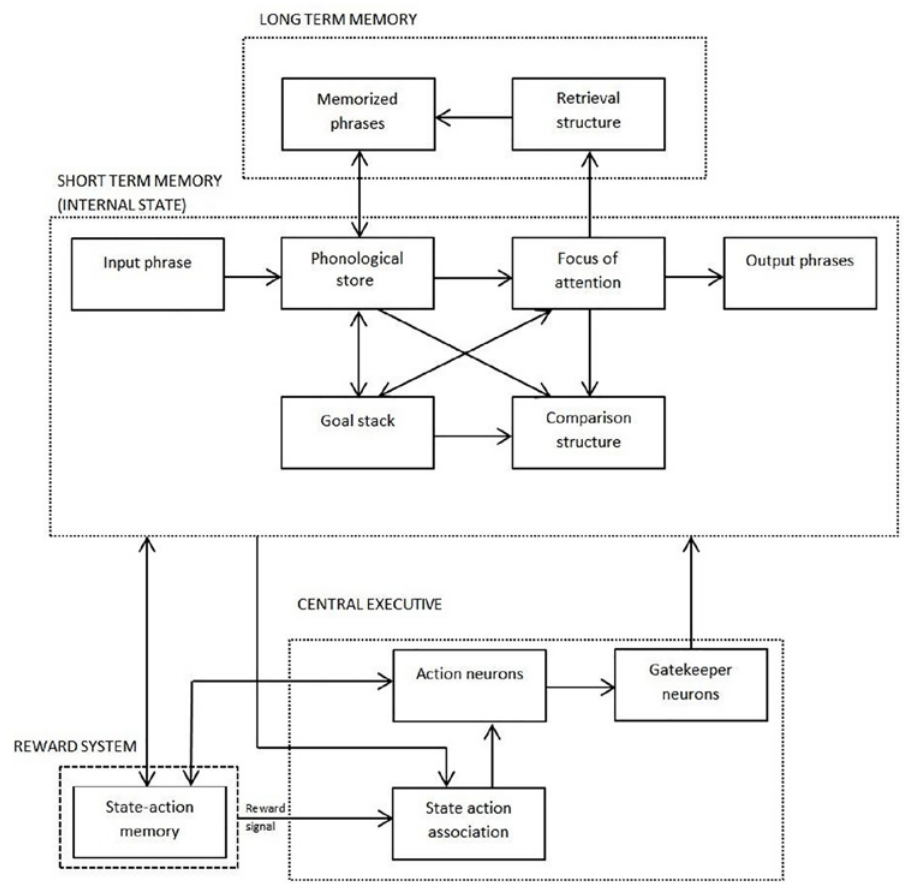
Fig 4. Schematic diagram of the ANNABELL system main